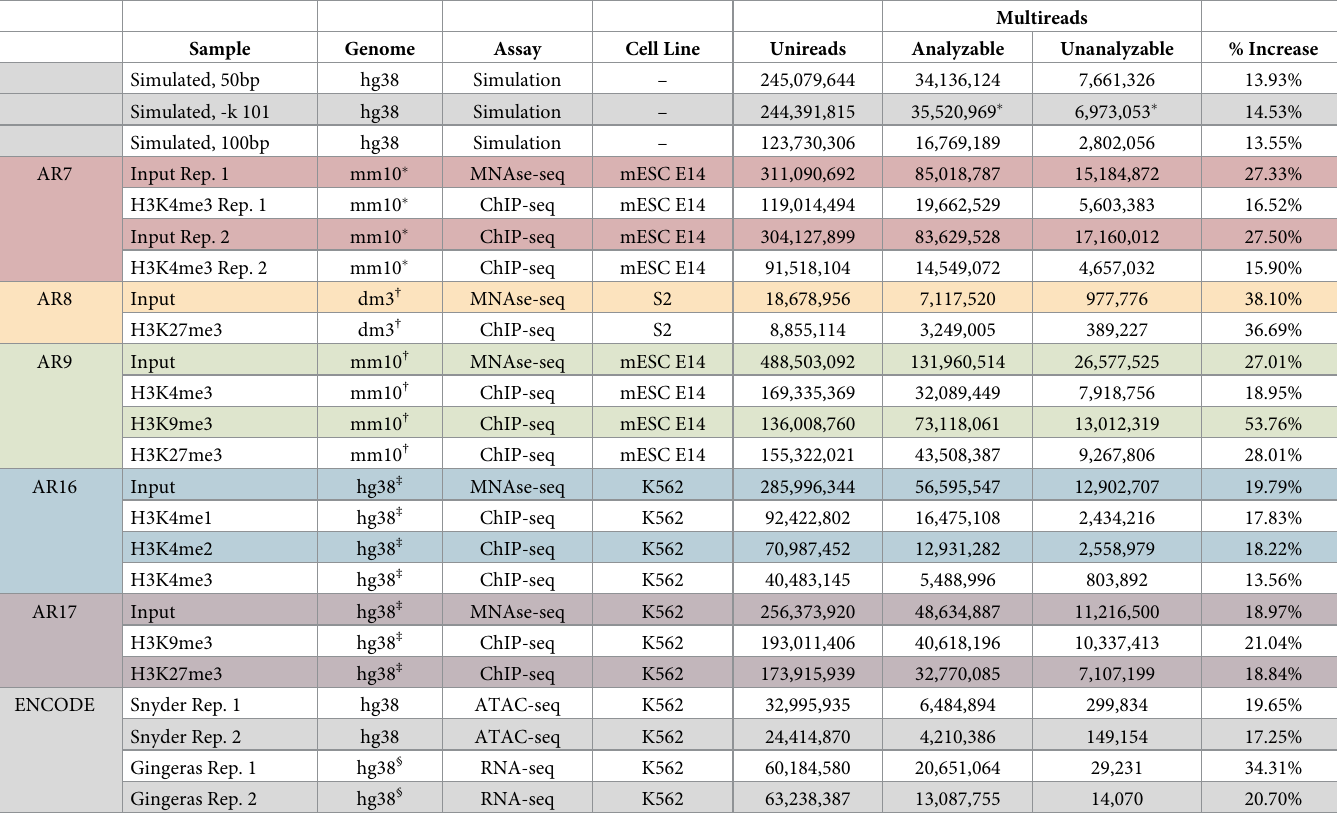
Table 1. Alignment statistics for the datasets used in this